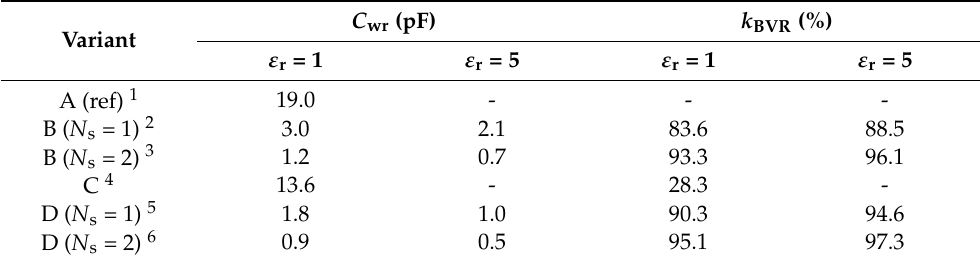
Table 2. Summary of computer simulation results.